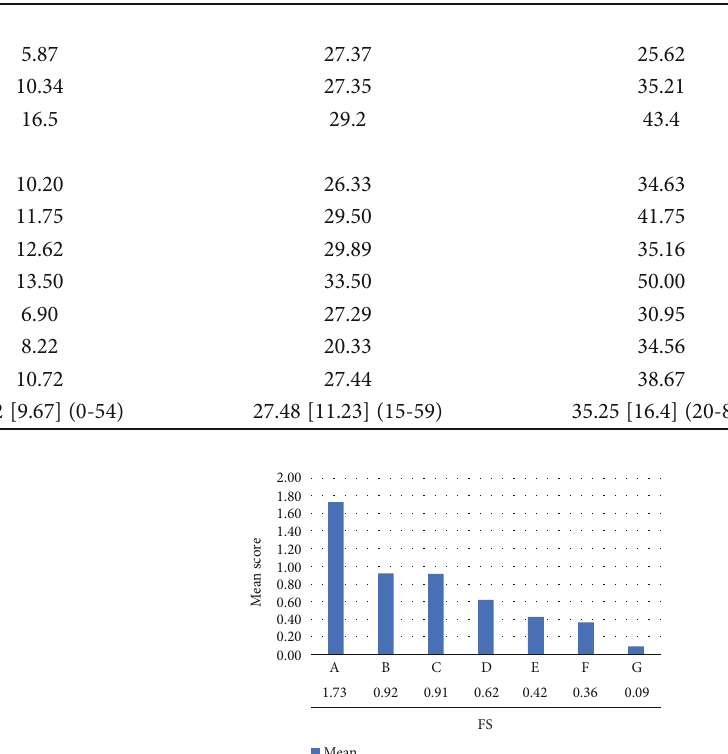
Figure 2: Depression score according to MS type.